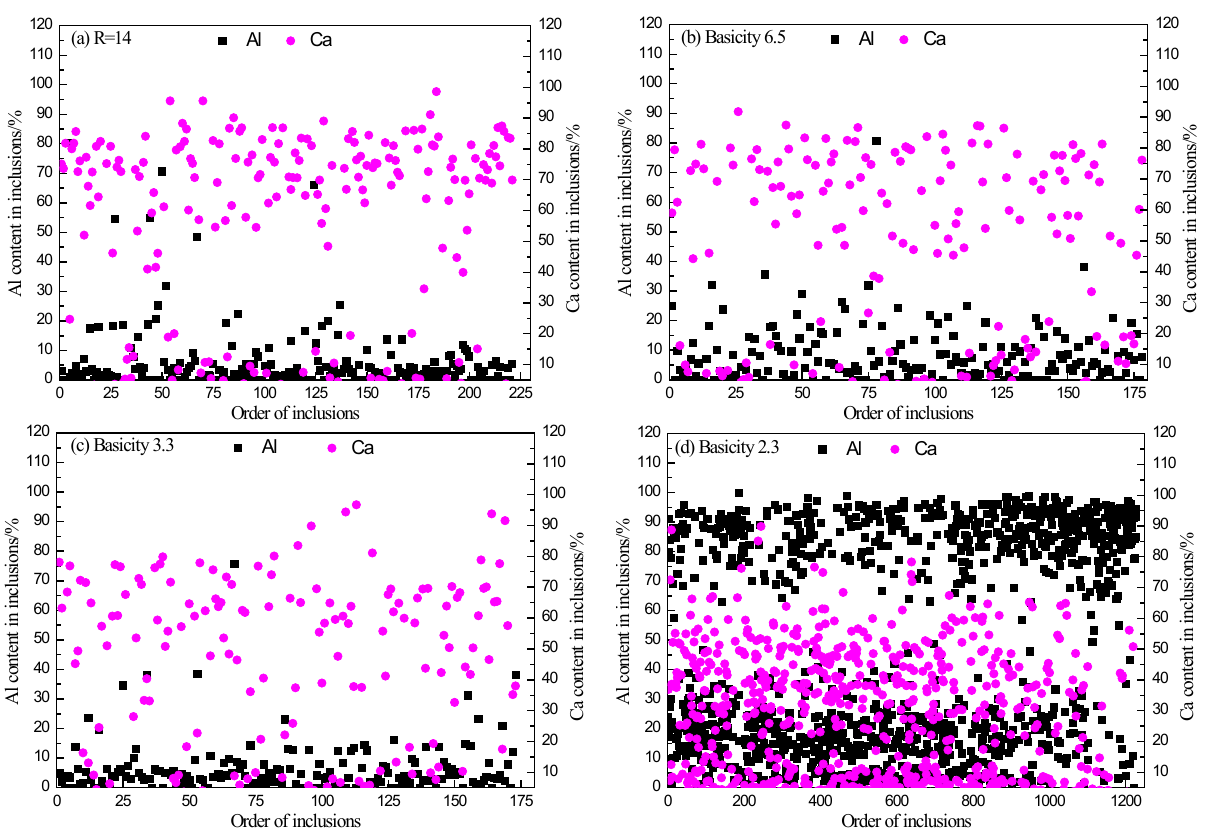
Figure 7. Composition of inclusions in electroslag ingots ( a ) R = 14, ( b ) R = 6.5 , ( c ) R = 3.3, ( d ) R = 2.3. Figure 7 shows that when slags with the basicities of 14, 6.5 and 3.3 were adopted, respectively, the Ca content in the inclusion was significantly higher than the Al content. However, after remelting by slag with a basicity of 2.3, the Al content in the inclusions was higher than the Ca content. Regardless of basicity, the inclusions were mainly spherical calcium aluminate, as shown in Figure 8.